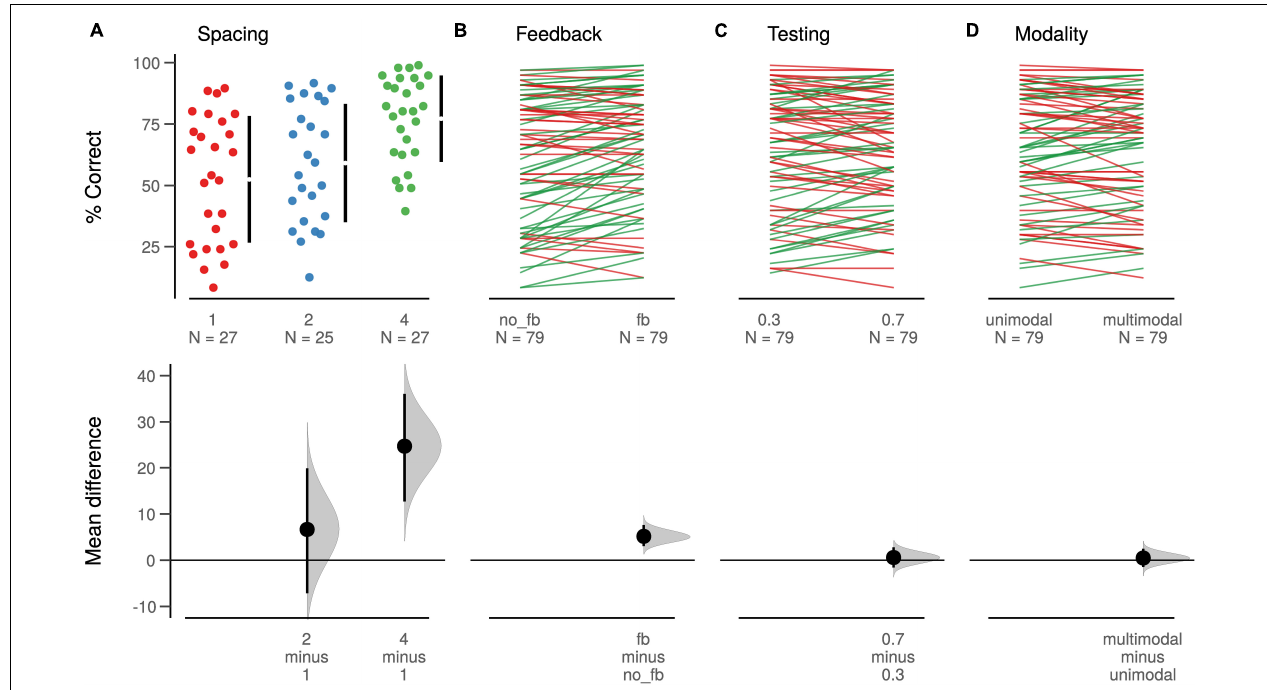
FIGURE 3 | Estimation plots for the learning principles via Cumming plots. Upper row shows individual participant data in a swarmplot for unpaired data ( A , Spacing) and a slopegraph for paired data ( B , Feedback, C , Testing, and D Modality). For unpaired data, the mean ± SD are shown as gapped lines. Lower row shows unpaired or paired mean differences as a bootstrap sampling distribution, with the dot indicating the mean difference and the ends of the error bars the 95% confidence